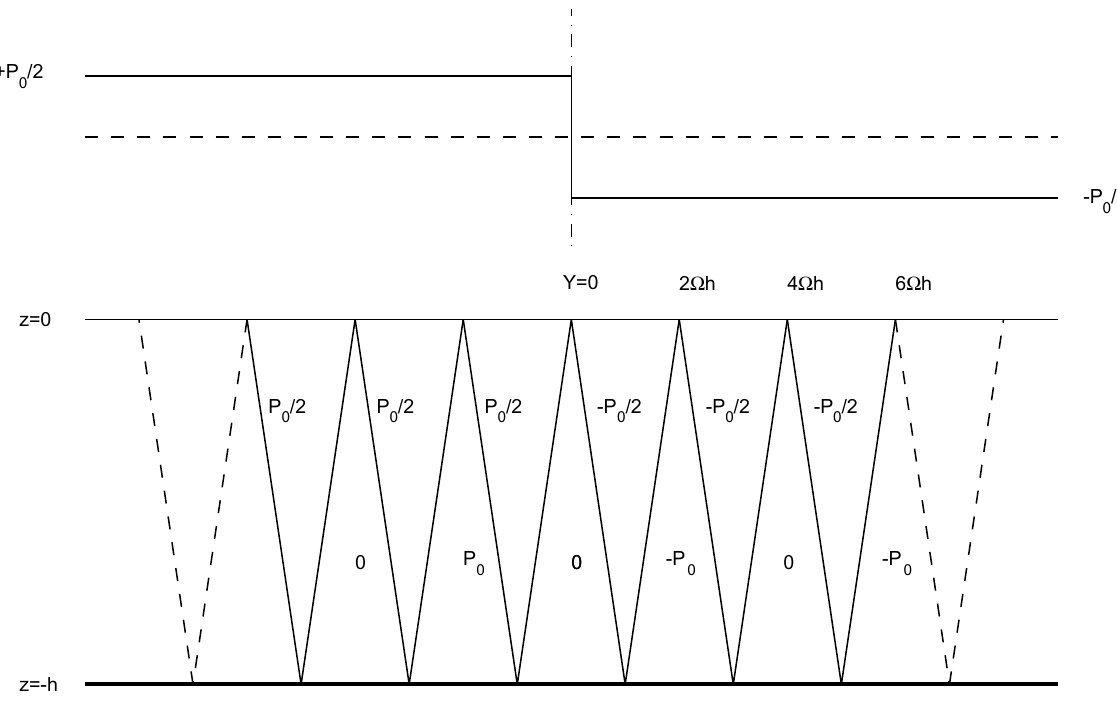
Fig. 6. Anti-symmetrical pressure distribution in the liquid.